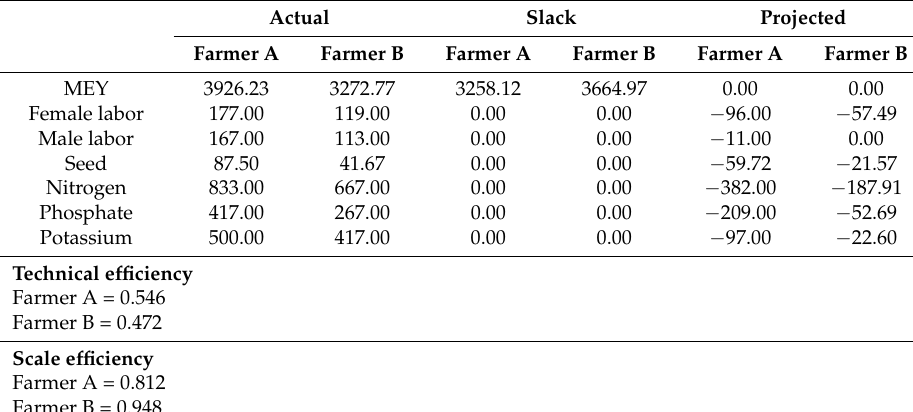
Table 6. Comparison of the variable return to scale (VRS) technical efficiency, slack maize equivalent yield (MEY), and projected change to input estimations for two farmers in Badamahulidiha, India practicing a reduced tillage, maize-cowpea intercrop cropping